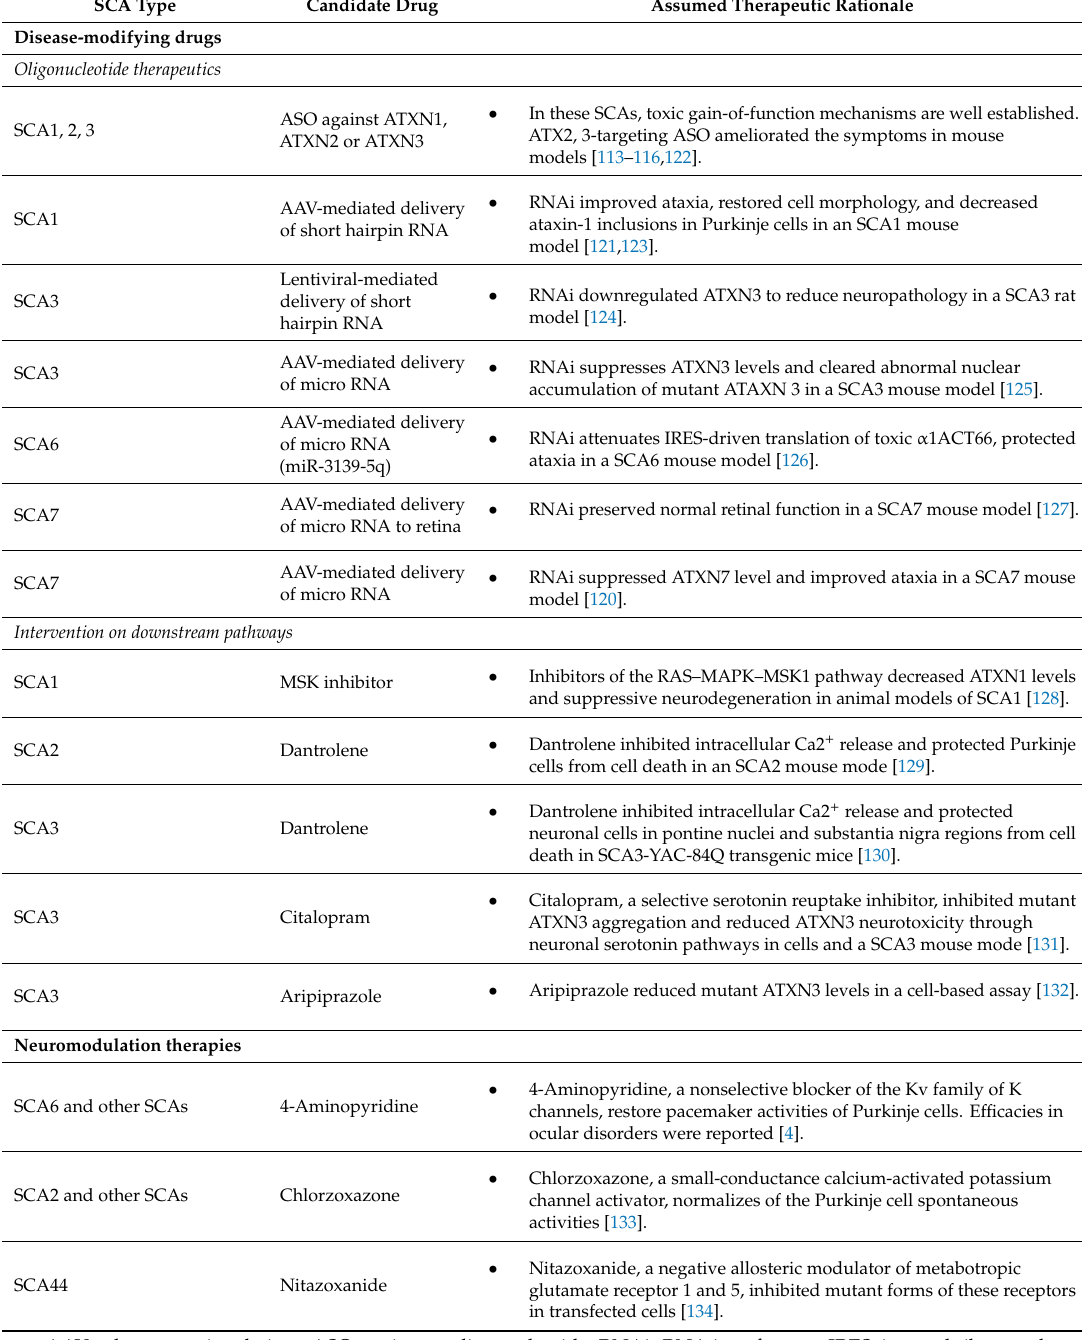
Table 5 shows candidate disease-modifying and neuromodulatory drugs for ADCAs [122–134]. The former includes oligonucleotide therapeutics and the intervention of downstream pathways. Table 5. Candidate drugs and for autoimmune dominant cerebellar